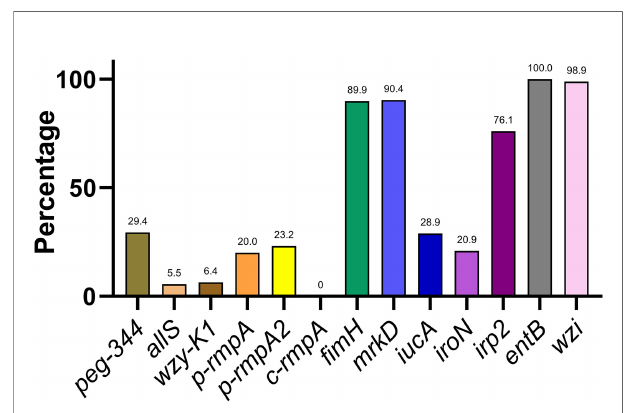
FIGURE 2 | Distribution of 13 key virulence genes among the Klebsiella pneumoniae isolates.